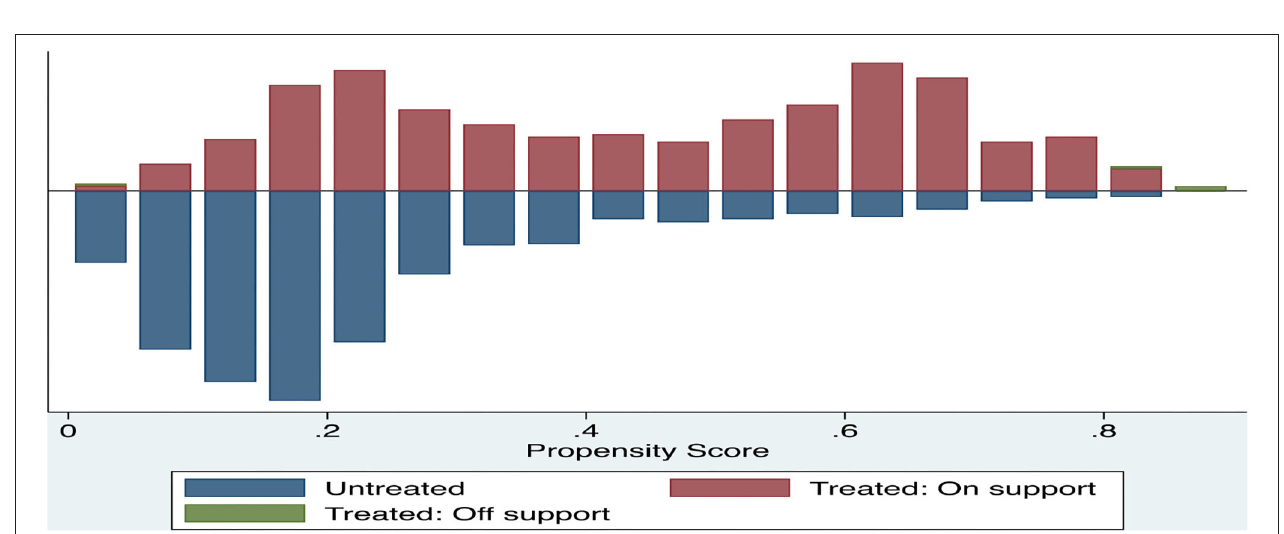
FIGURE 7 | Test of region of common support: per-capita food